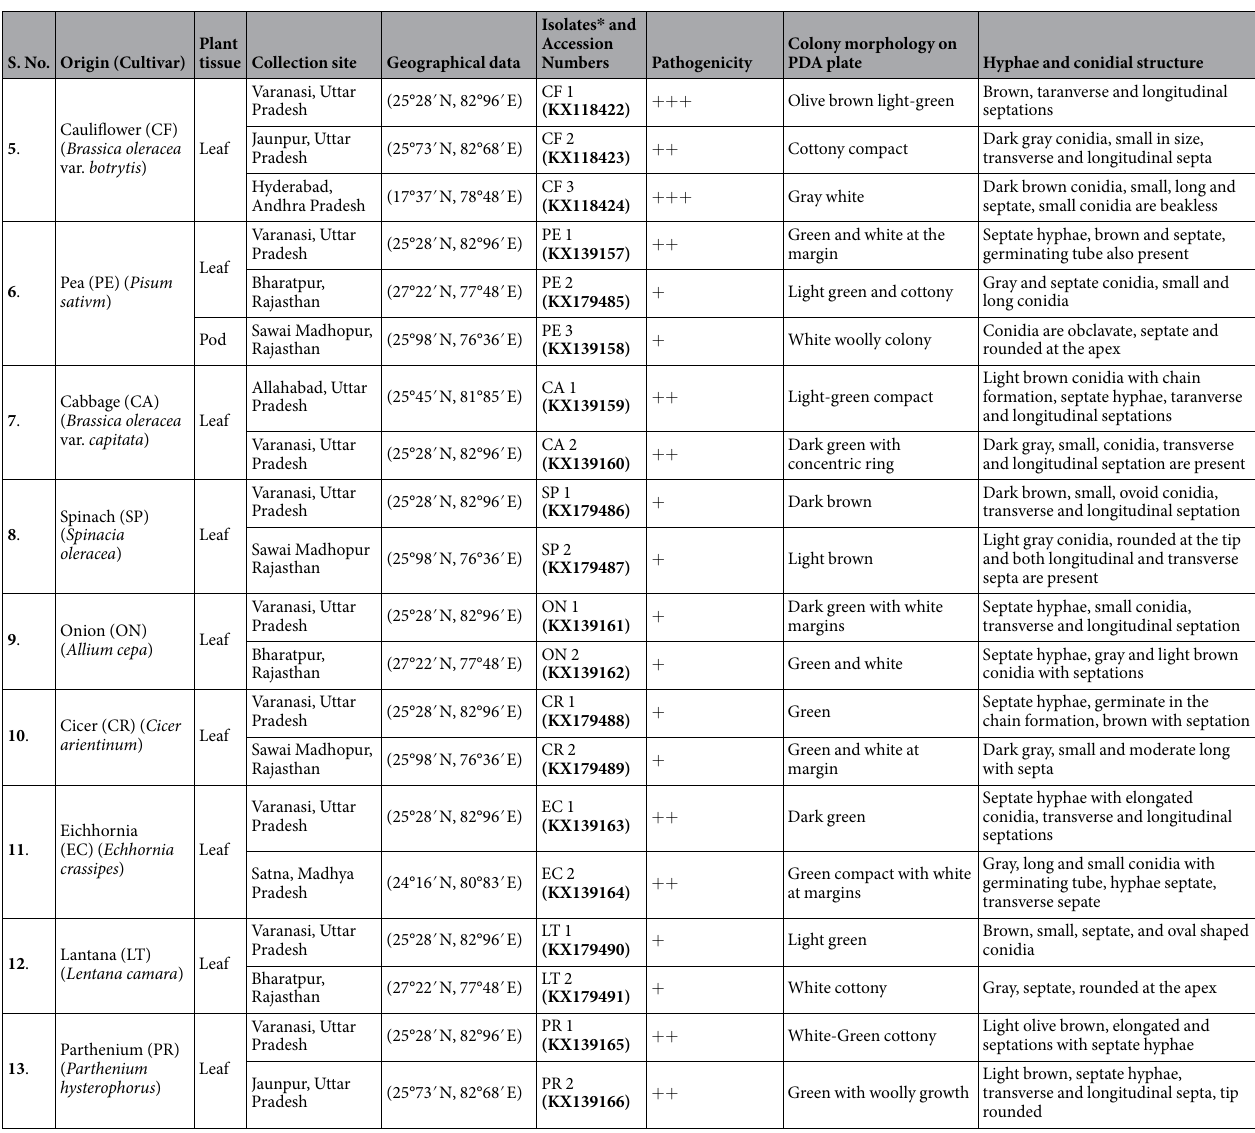
Table 1. Plant origin, pathogenicity, colony morphology and hyphal/conidial structures of the Alternaria species used in study. Note: +++ Highly pathogenic (60–100%); ++ Moderate pathogenic (30–60%); + Less All the morphological characters such as culture appearance on PDA plate, mycelia colour, and conidia appearance were observed and data were